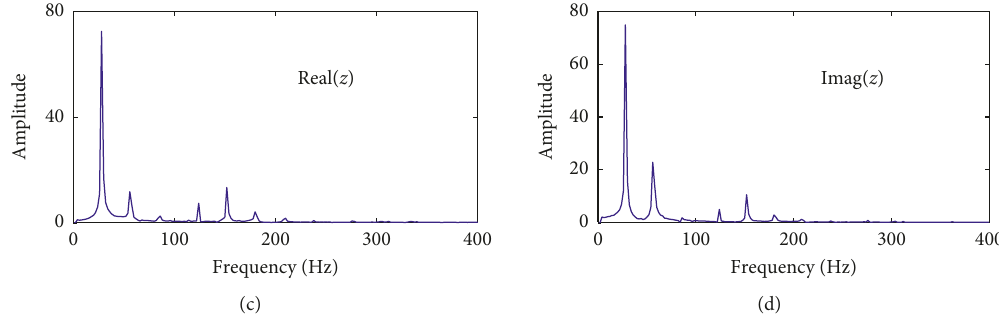
Figure 19: The composite fault signal z : (a) the 3D time domain wave of z ; (b) the 2D plane of z ; (c) the Fourier spectrum of Real[ z ]; (d) the Fourier spectrum of Imag[ z ].